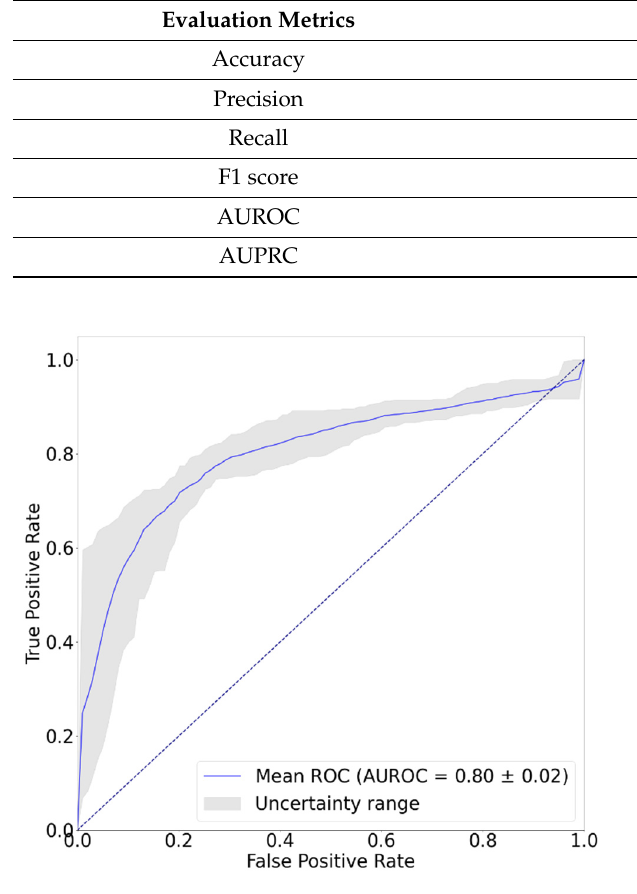
Figure 6. Receiver operating characteristic (ROC) curve of proposed model. Grey area represents the range of uncertainty. AUROC: Area under curve of ROC curve.